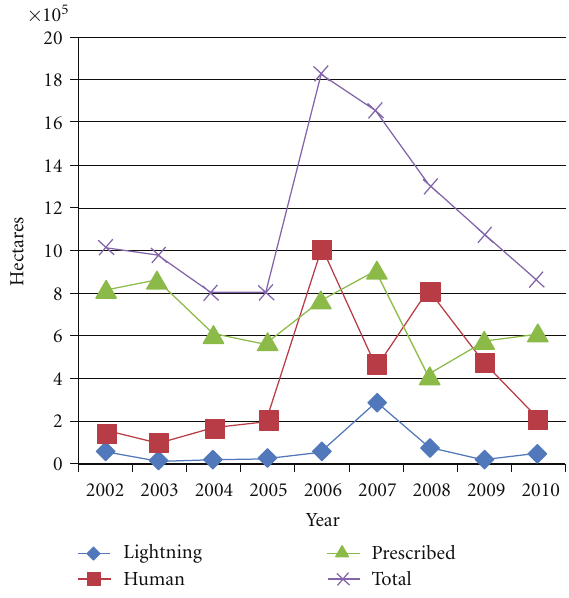
Figure 1: Area burned in the southern United States by fires of var- ious ignition sources, 2002 to 2010 (Data from National Interagen- cy Fire Center; http://www.nifc.gov/fireInfo/fireInfo statistics.html accessed 9 July